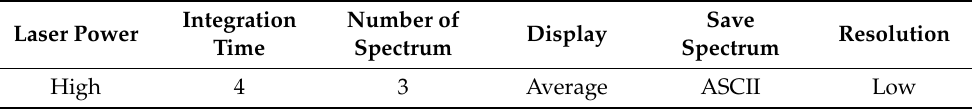
Table 2. Pro Scope HR set parameters for obtaining sample image